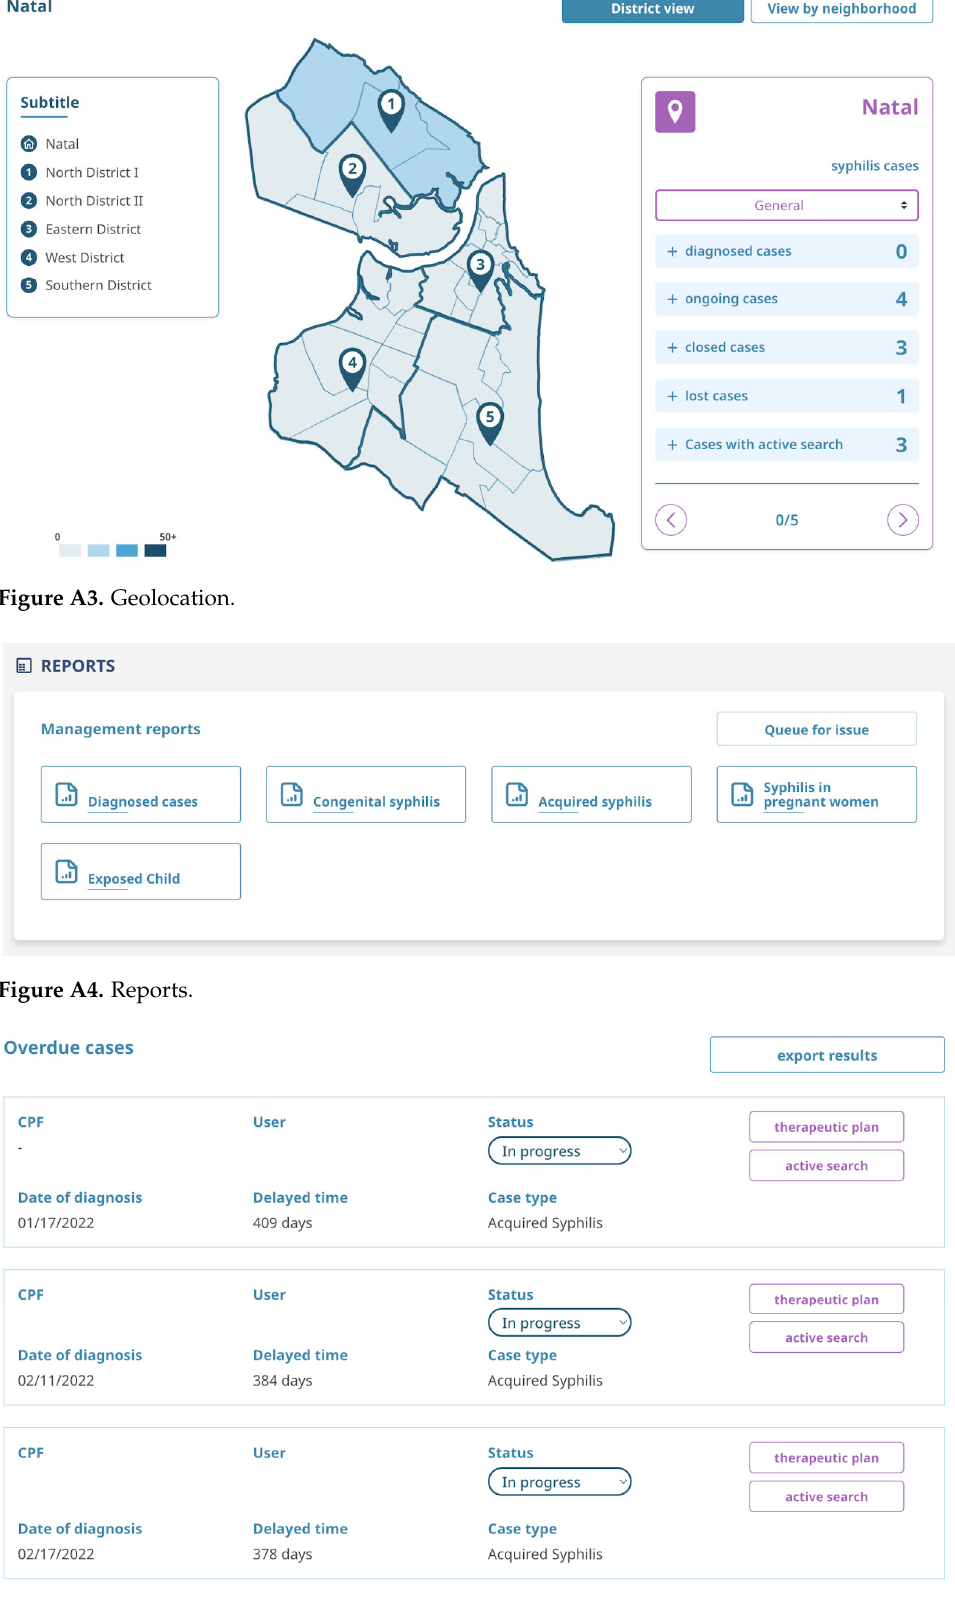
Figure A5. Overdue cases.